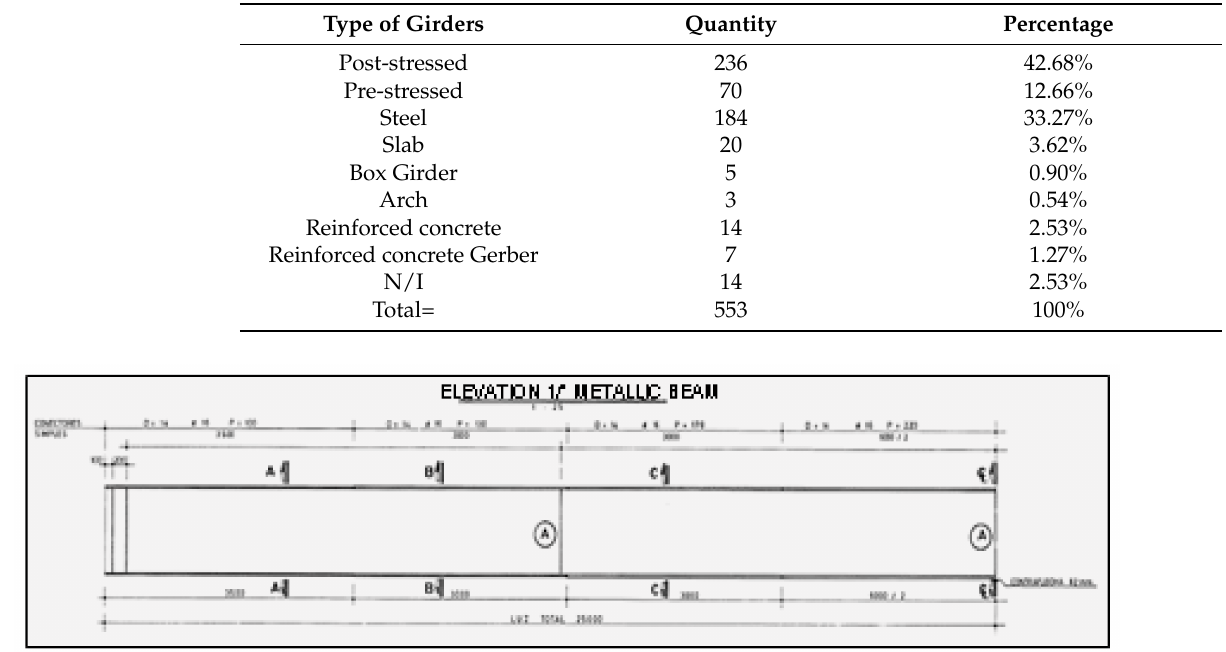
Table 1. Historical classification of girders in Chilean bridges.